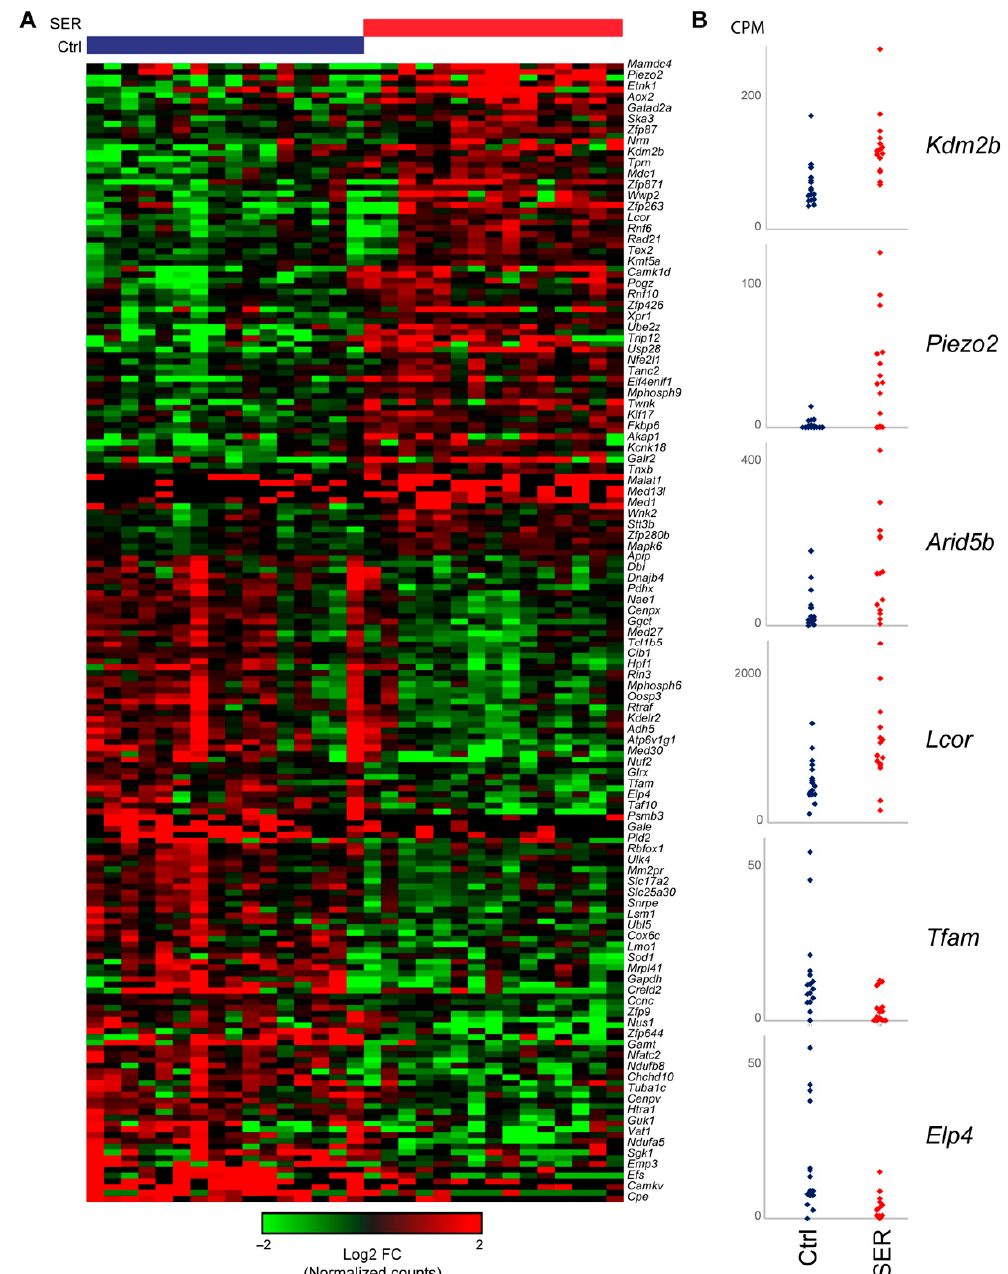
Figure 6. SER treatment impacts gene expression in two ‐ cell stage embryos. ( A ) Heatmap showing differentially expressed genes between control ‐ and SER ‐ generated two ‐ cell embryos. Log2 fold change of expression was calculated for each DEG for all 16 control (blue) and 15 SER (red) two ‐ cell embryos relative to the gene’s median expression across the dataset (all values expressed as log2FC(embryo+10)/(median+10) to suppress expression changes at poorly expressed genes). ( B ) Data for individual two ‐ cell embryos are shown for representative up ‐ or down ‐ regulated genes in SER ‐ generated embryos in comparison to control ‐ generated embryos (Ctrl).